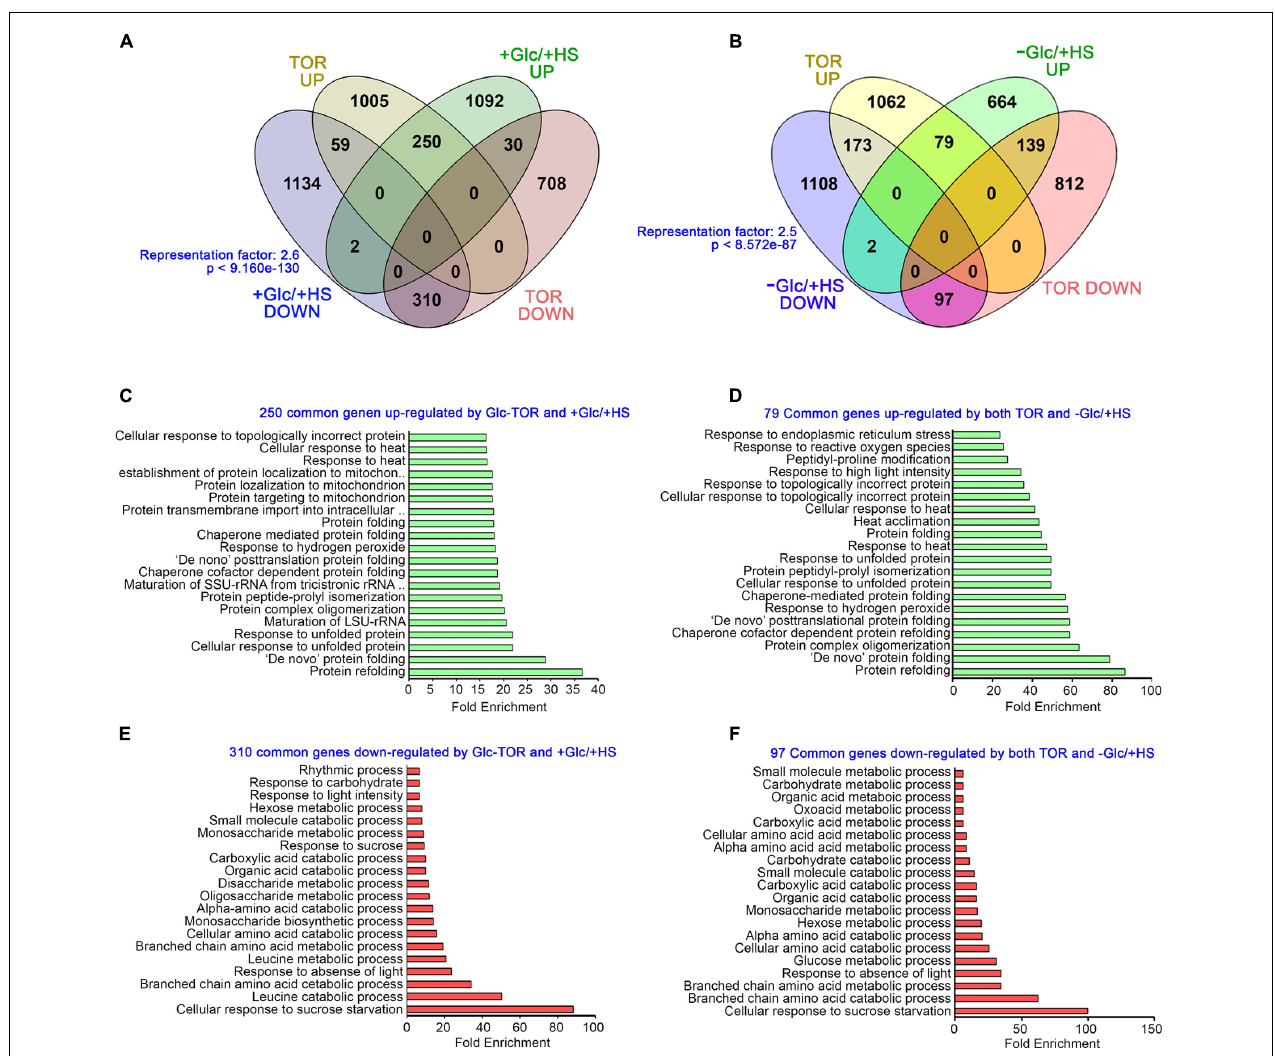
FIGURE 3 | Glc via TOR promotes the transcriptome reprogramming of genes involved in heat stress protection. (A) A Venn diagram showing synergistic and antagonistic interaction of + Glc/ + HS transcriptome with publicly available Glc/TOR transcriptome of 3-day-old seedlings of WT and tor treated with Glc for 2 h. (B) A Venn diagram showing synergistic and antagonistic interaction of –Glc/ + HS transcriptome with publicly available Glc/TOR transcriptome. The statistical significance of the overlap between the two groups of genes was calculated using hypergeometric distribution provided by Nematode bioinformatics, Analysis tools, and data (http://nemates.org/). Data shown are an average of three biological replicates. (C,E) The GO biological process of genes commonly down and upregulated by + Glc/ + HS and public-available Glc-TOR microarray genes (Xiong et al., 2013). (D,F) The GO biological process enrichment of genes